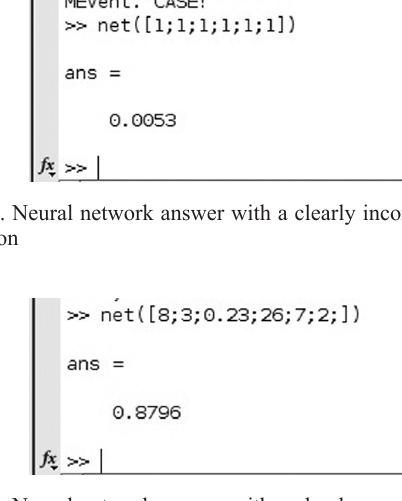
Fig. 8. Neural network answer with a clearly correct